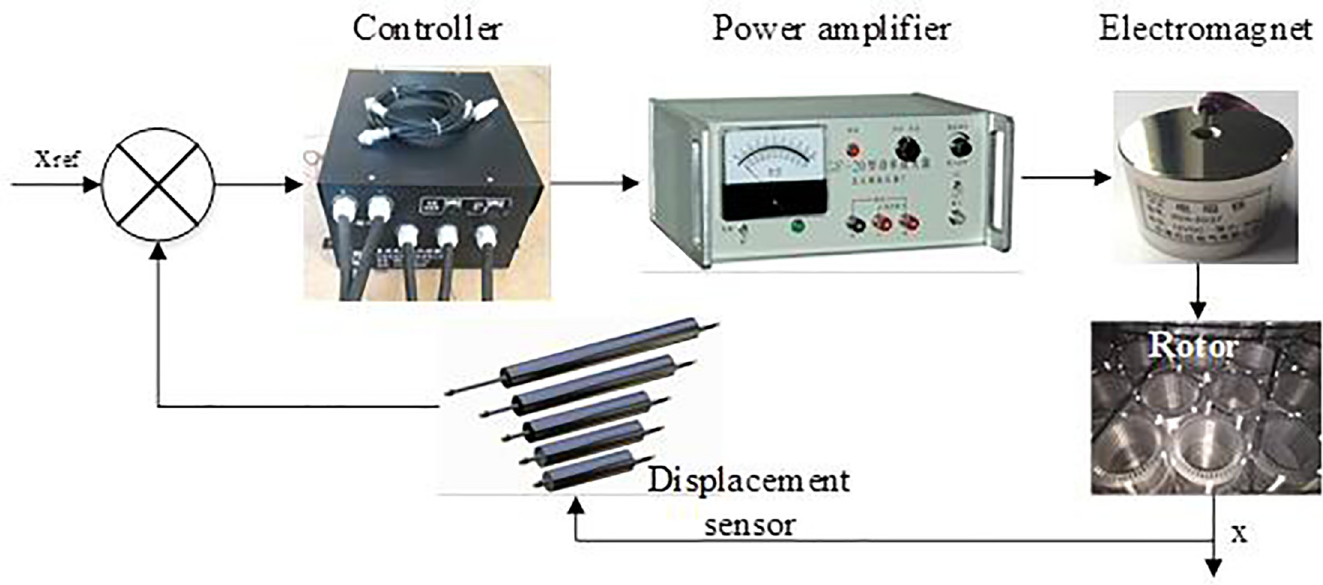
Fig 1. Working principle of magnetic bearing-rotor